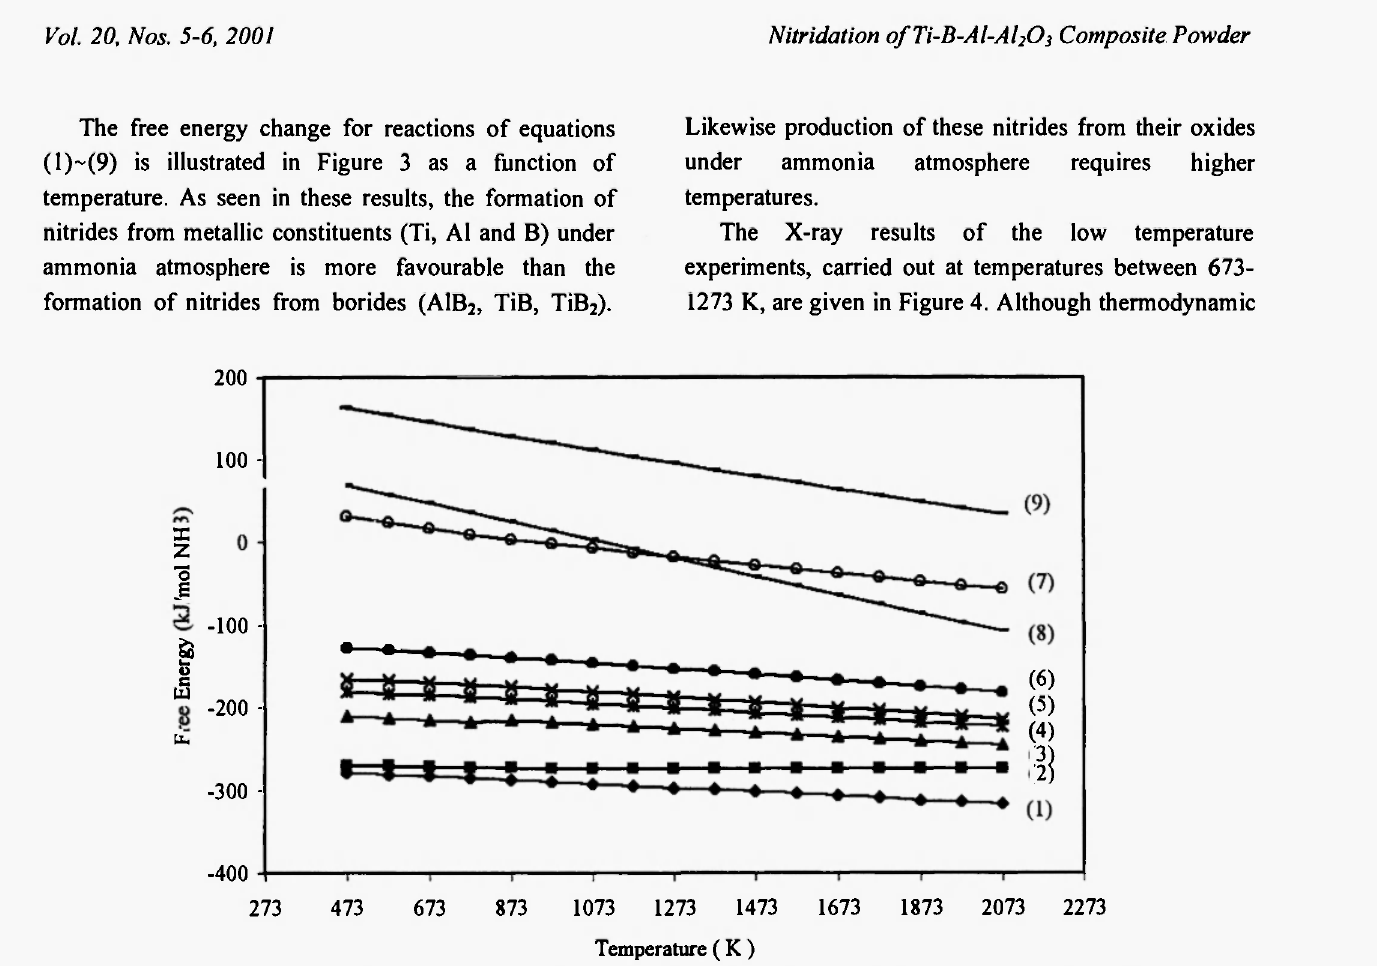
Fig. 3: The change of free energy /18/ with temperature for reactions given in equations (1) through (9).